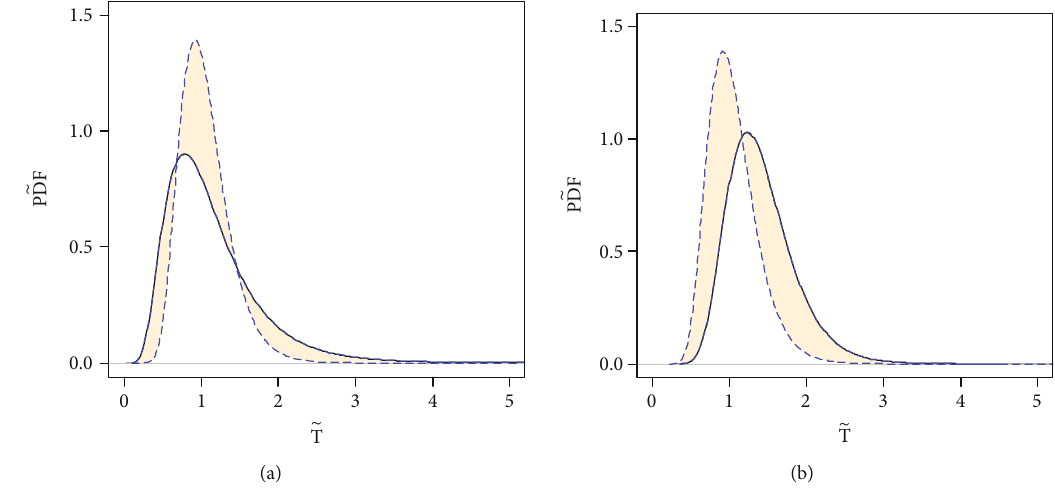
Figure 1: The density function of NLD with neutrosophic parameters (a) σ